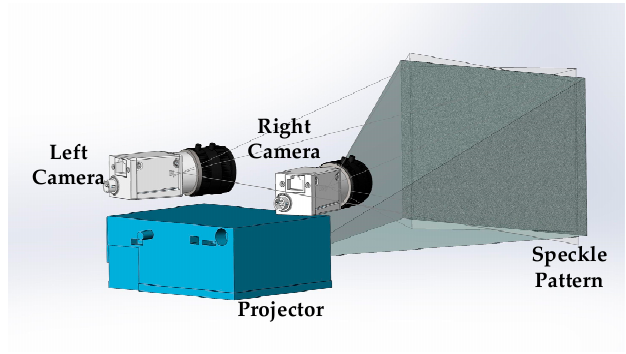
Figure 1. Structure of the single-shot stereo system.